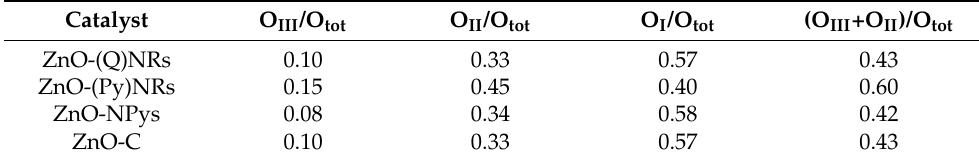
Table 3. Intensity ratios of normalized O 1s components relative to the total oxygen area (O tot ). Catalyst O III /O tot